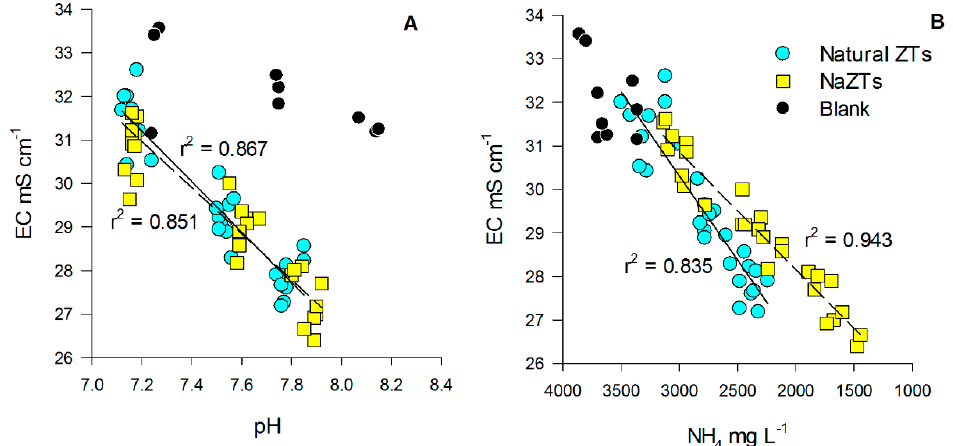
Figure 1. Relationship between electrical conductivity (EC) vs. pH ( A ) and EC vs. NH 4 ( B ) in the treated pig-slurry. Black dots represent blank samples (no ZT added), cyan dots represent natural ZTs (all the grain sizes), while yellow squares represent NaZTs (all the grain sizes). Continuous regression lines refer to natural ZTs, while the dotted regression line refers to NaZTs. ZT: zeolite; NaZT: Na-exchanged